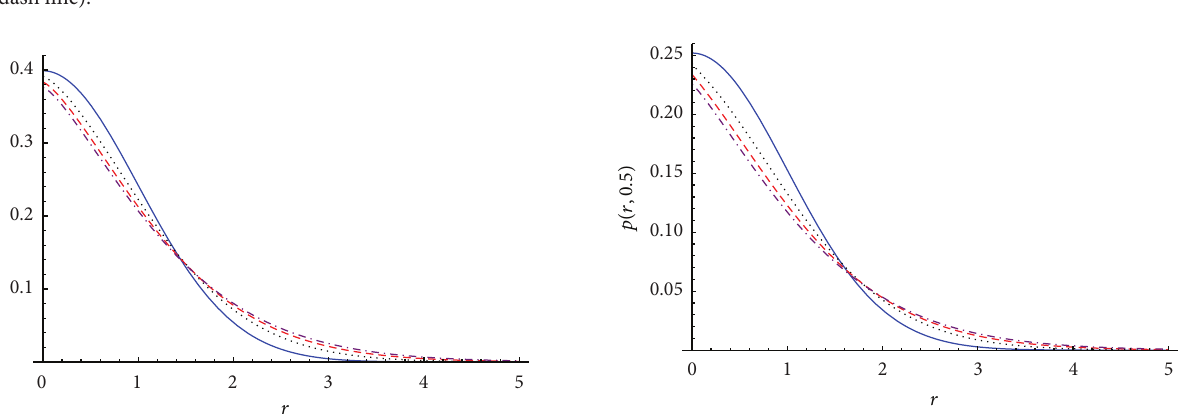
Figure 1: Curves of 𝑝(𝑟, 0.25) versus 𝑟 for 𝑑 𝑓 = 1 and for 𝑑 𝑤 = 2 (solid line), 𝑑 𝑤 = 2.5 (dot line), 𝑑 𝑤 = 3 (dash line), and 𝑑 𝑤 = 3.5 (dot-dash line).